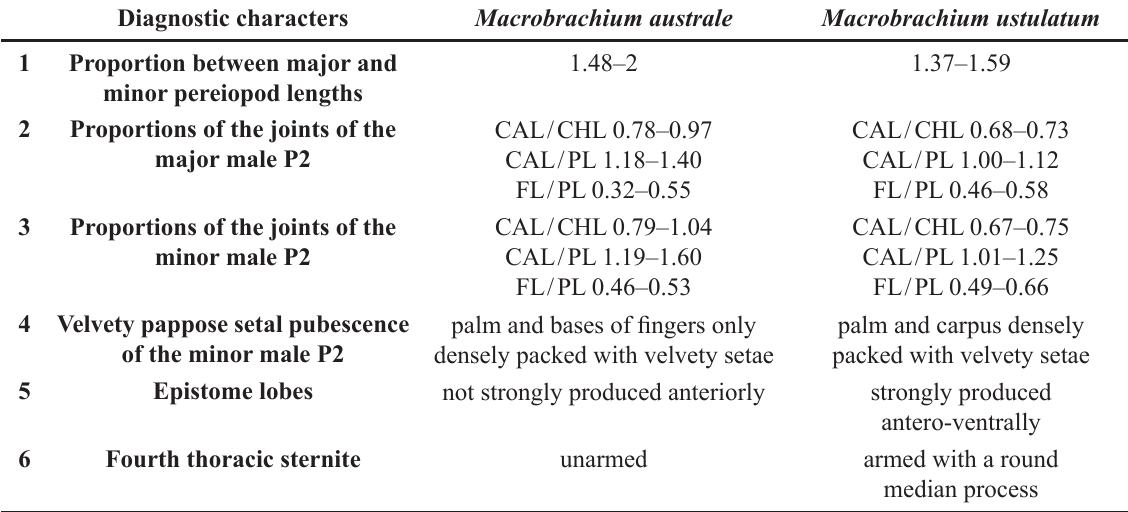
Table 3. Traits of six characters identified as diagnostic to distinguish Macrobrachium australe (Guérin- Méneville, 1838 in Guérin-Méneville 1829–1838) from M. ustulatum (Nobili,